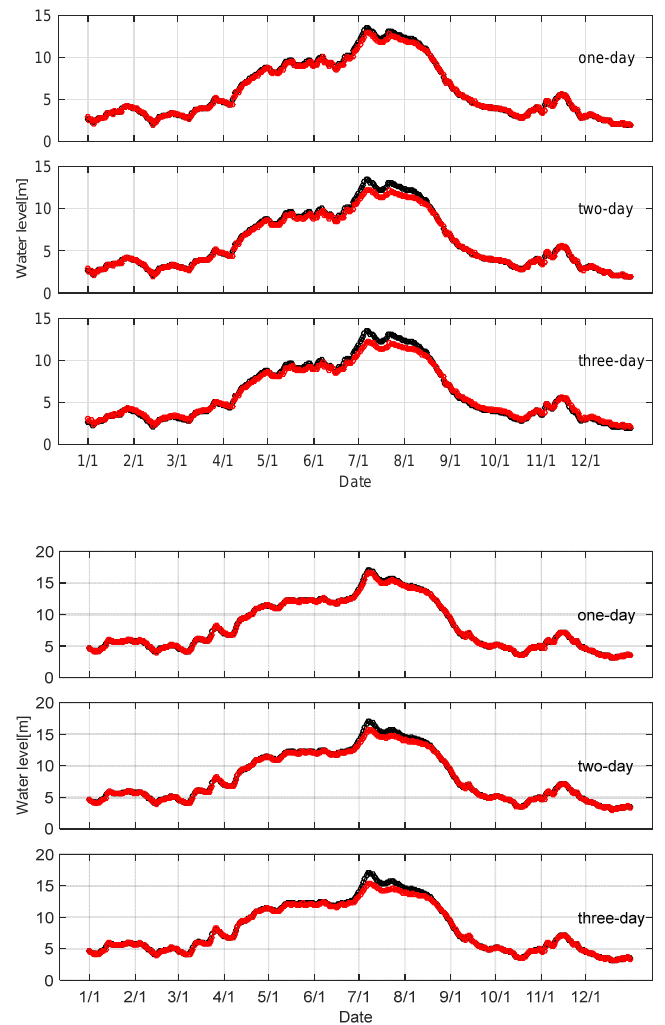
Figure 8. Effects of forecast lead time on LSSVMi model accuracy at Jianli ( top panel ) and Chenglingji ( bottom panel ). Table 2 . Computations of RMSE, MAPE and d for different forecast lead time (LSSVM i ).